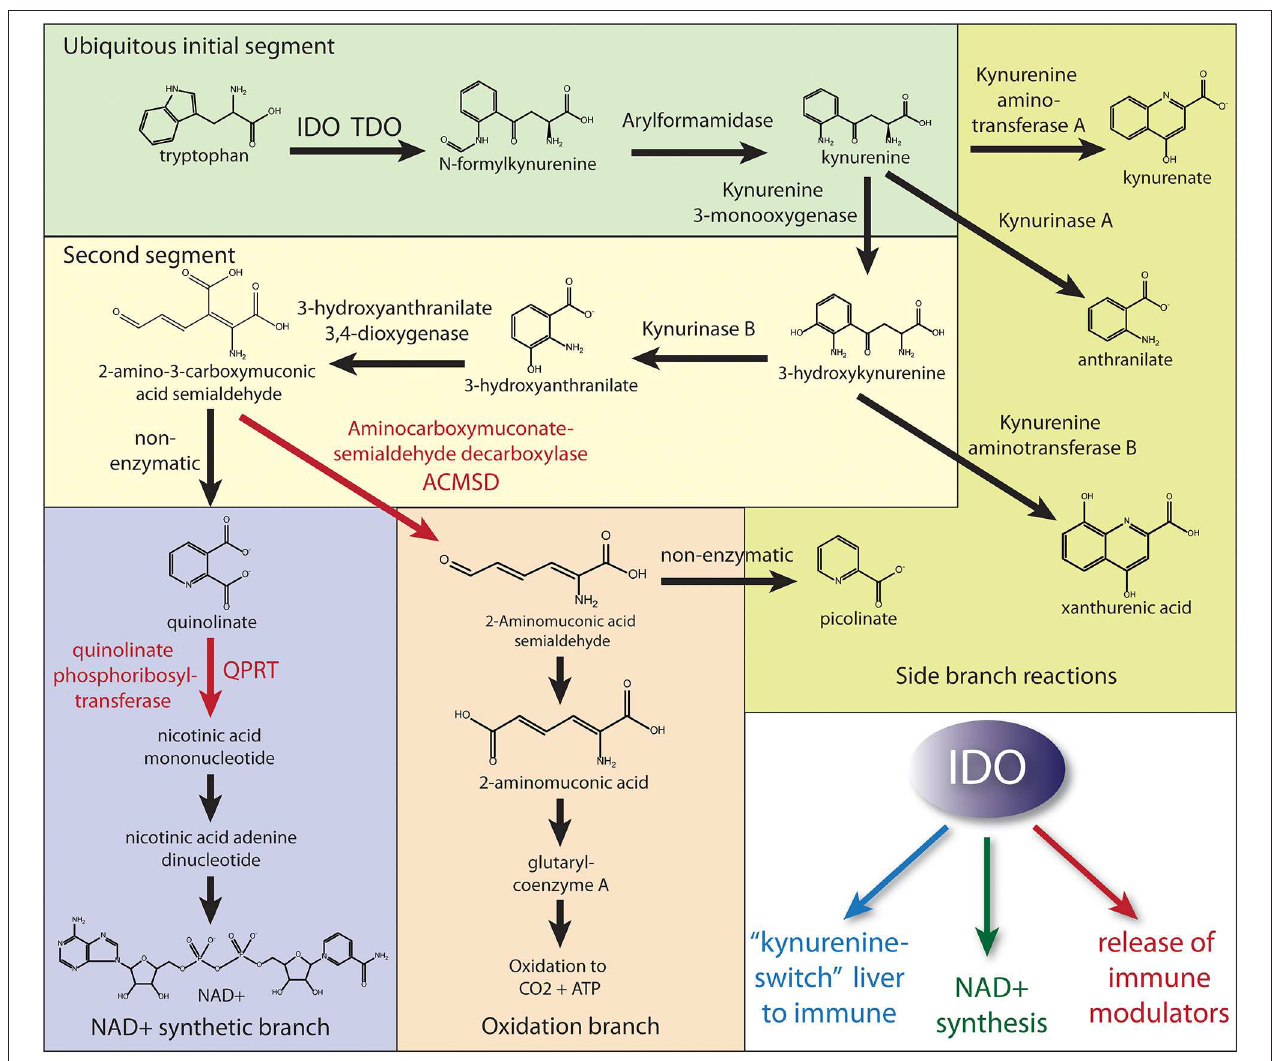
FIGURE 1 | Simplified diagram of the kynurenine pathway of tryptophan catabolism. Most cell types can initiate the kynurenine pathway via either TDO or IDO to produce kynurenine (initial segment of tryptophan metabolism). Hepatocytes have the full complement of enzymes to either produce NAD + or fully oxidize tryptophan to CO 2 . Numerous cell types, including many of the immune system, express the enzymes through the NAD + synthetic branch. However, in order for Quin to build up in some immune cells during an immune response, the activities of the enzymes aminocarboxymuconate semialdehyde decarboxylase (ACMSD) and quinolinate phosphoribosyltransferase (QPRT) must be restricted to slow further metabolism to either NAD + or oxidation to CO 2 . The fate of stockpiled Quin in those immune cells remains uncertain, but it is likely that both NAD + synthesis and oxidation to yield energy are employed by various cells of the immune system during an immune response. Also, these cells may be releasing upstream metabolites. As such, upregulation of QPRT activity (red arrow) would be the rate-limiting factor for further metabolism to NAD + when needed, and we propose this branch is predominantly utilized in cells of the immune system following IDO activation. In contrast, the activity of ACMSD would control the oxidative branch throughput for energy derivation. The three primary functions of IDO activation are (1) the extra-hepatic production of kynurenine, which is released for uptake by cells of the immune system thus diverting tryptophan metabolism to the immune system, (2) the production of NAD + in cells of the immune system for the PARP reaction to DNA damage and other critical functions in immune cells, and (3) the production and release of immune modulating metabolites to regulate the immune response, especially T cell responsiveness. NMNAT, nicotinamide mononucleotide adenylyltransferase; NADSYN1, NAD synthetase